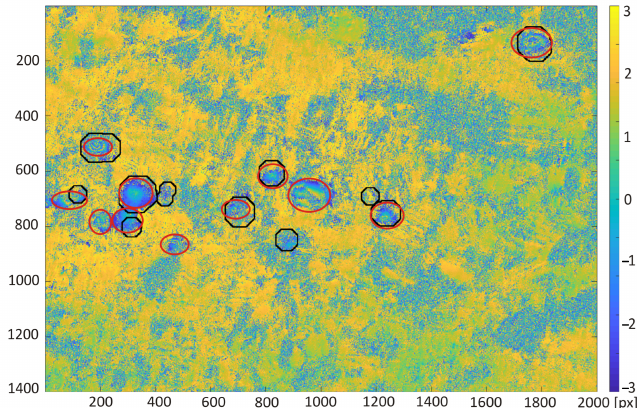
Figure 11. Interferogram of the second area computed from pictures recorded by Sentinel-1 on the 10th and 22nd of October 2016. Red ellipses are the subsidence area marked by experts; black squares were detected by the re-trained ResNet-50 network.